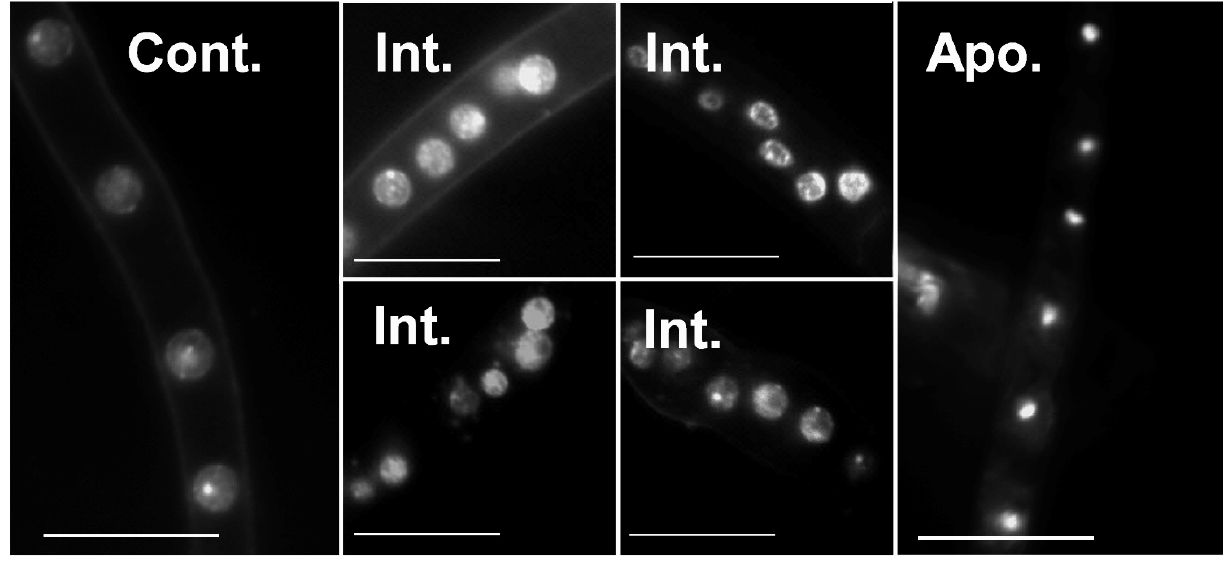
FIGURE 3: Changes in nuclei morphology in response to PCD-inducing conditions. Cultures were grown for 24 h in PDB, then H 2 O 2 was add- ed to a final concentration of 10 mM. The mycelia were harvested after 4 h of incubation with H 2 O 2 , processed and stained with Hoechst 33342. Samples were visualized at 1000x magnification. Control, time zero, cells are loosely and evenly stained, the nucleolus is clearly visi- ble (arrow); Int., intermediate stages of apoptosis, accumulation of nuclear fragments is visible; Apoptotic, highly condensed nuclei represent the final stage of apoptosis. Scale bar = 10